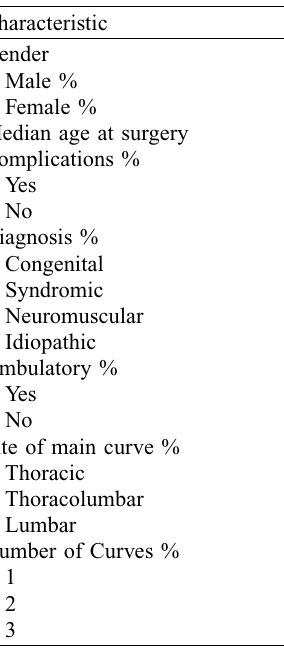
Table 1. Characteristics of patients surveyed using